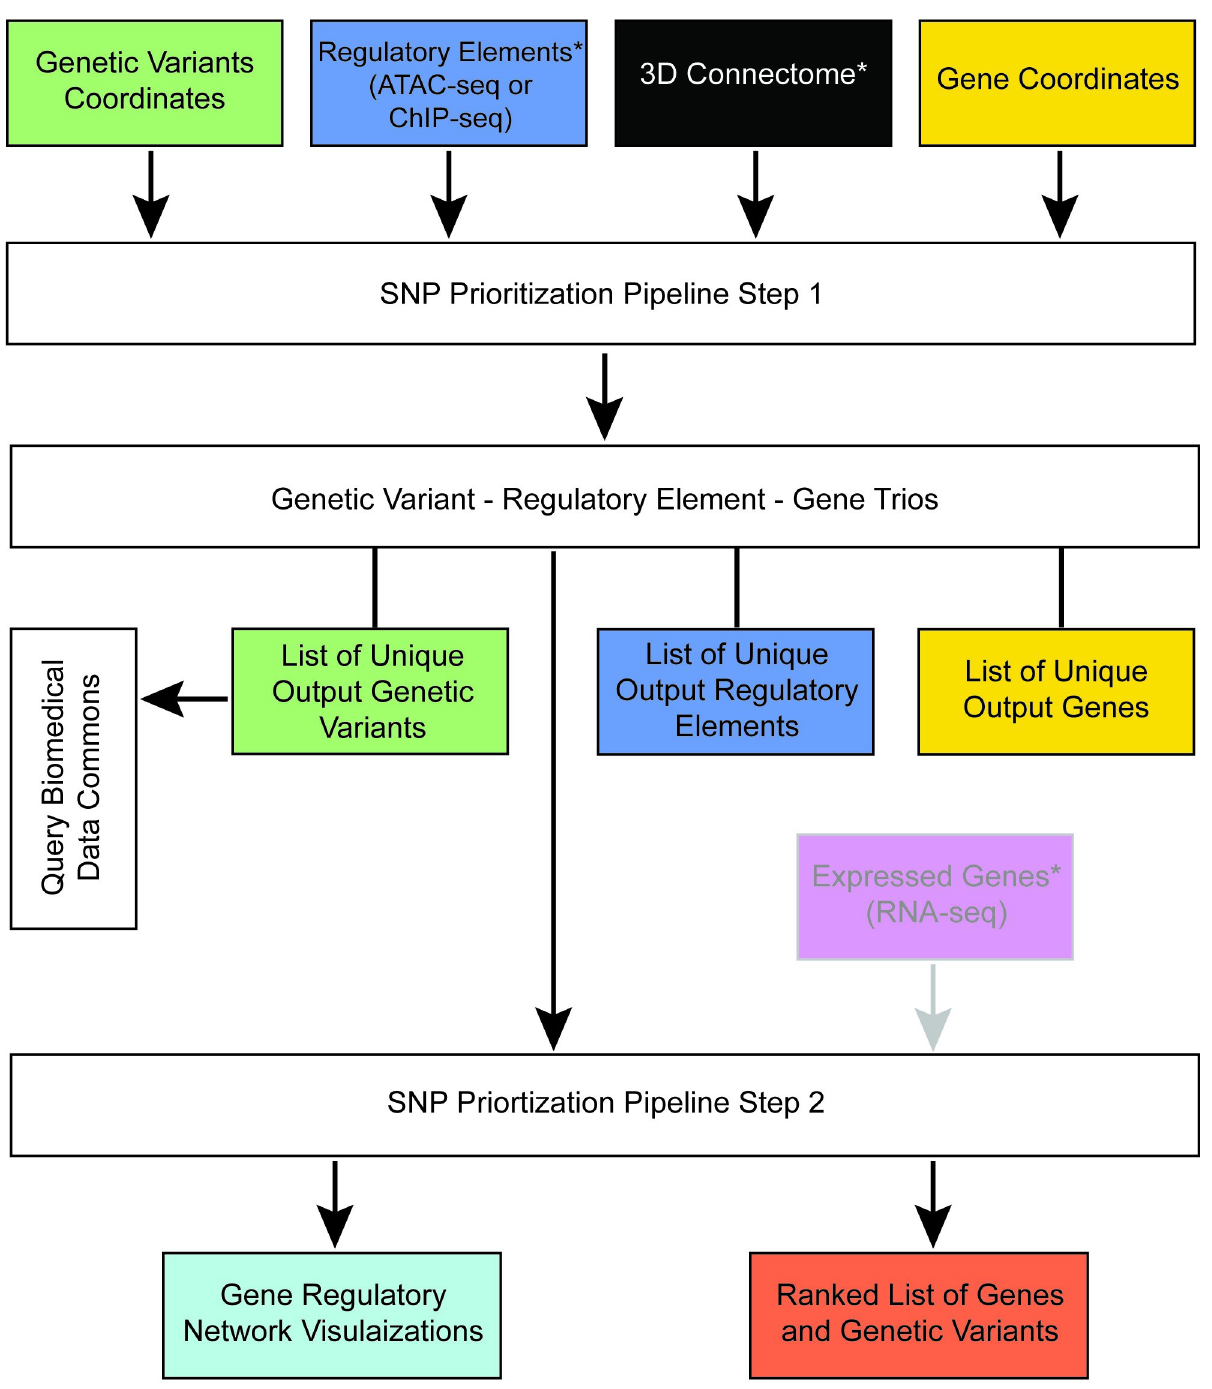
Fig 2. Schematic of the SNP Prioritization Pipeline. Genomic coordinates of genetic variants, regulatory elements, 3D connectome, genes are input into step one of the SNP Prioritization Pipeline. The output from Step 1 are associated genetic variants—regulatory elements—genes, which together formed trios. List of the unique genetic variants, regulatory elements, and genes that participate in these trios are also outputted. The gene list from step 1 of the SNP Prioritization Pipeline can be used as input for Biomedical Data Commons queries. The trios generated in step 1 are used as input into step 2 of the SNP Prioritization Pipeline along with optional input cell type-specific gene expression data. The output is visualizations of gene regulatory networks and a ranked list of genetic variants and genes. Input and output data at each step of the pipeline is color coded by type of data: genetic variants (green), regulatory elements (blue), genes (gold), 3D connectome (black), gene expression data (magenta), gene regulatory networks (turquoise), and ranked list of genetic variants and genes (orange). Optional input data is denoted by grey text, grey outline of the input box, and grey input arrow. � denotes input data that is cell type-specific and needs to belong to the same cell type of interest throughout the pipeline. https://doi.org/10.1371/journal.pcbi.1009382.g002 PLOS Computational Biology | https://doi.org/10.1371/journal.pcbi.1009382 September 20,